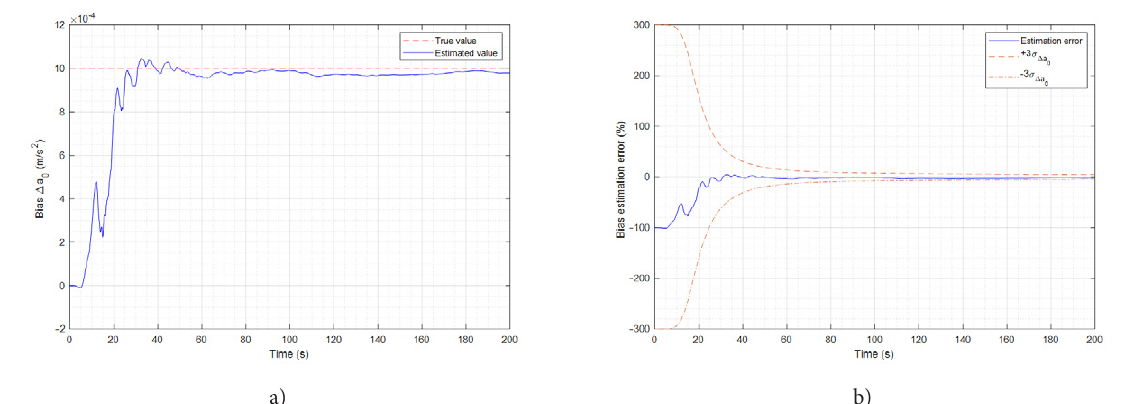
Figure 5. Bias estimation during stabilized level flight: a – estimated value; b – estimation